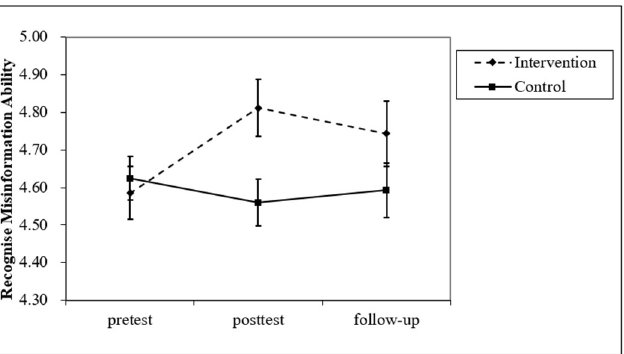
Figure 4. Interaction effect between group and time on misinformation discrimination in Study 2.